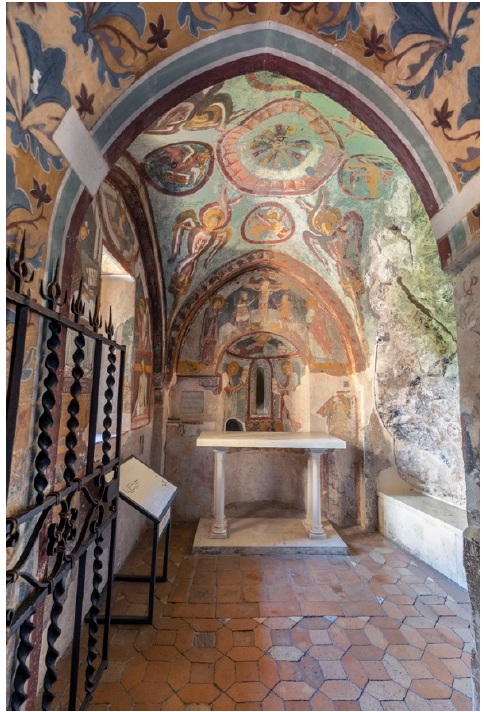
Figure 5. Sacro Speco, Subiaco (Italy), chapel of St. Gregory. Photo: Davide Giannetti.